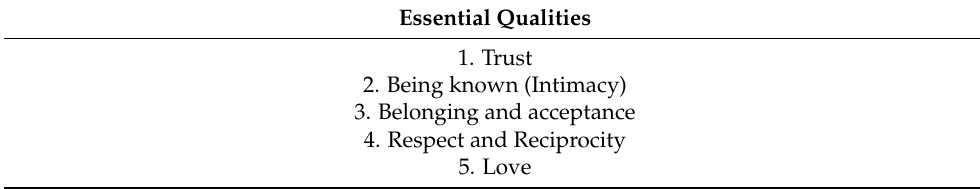
Table 1. Essential Qualities of Meaningful